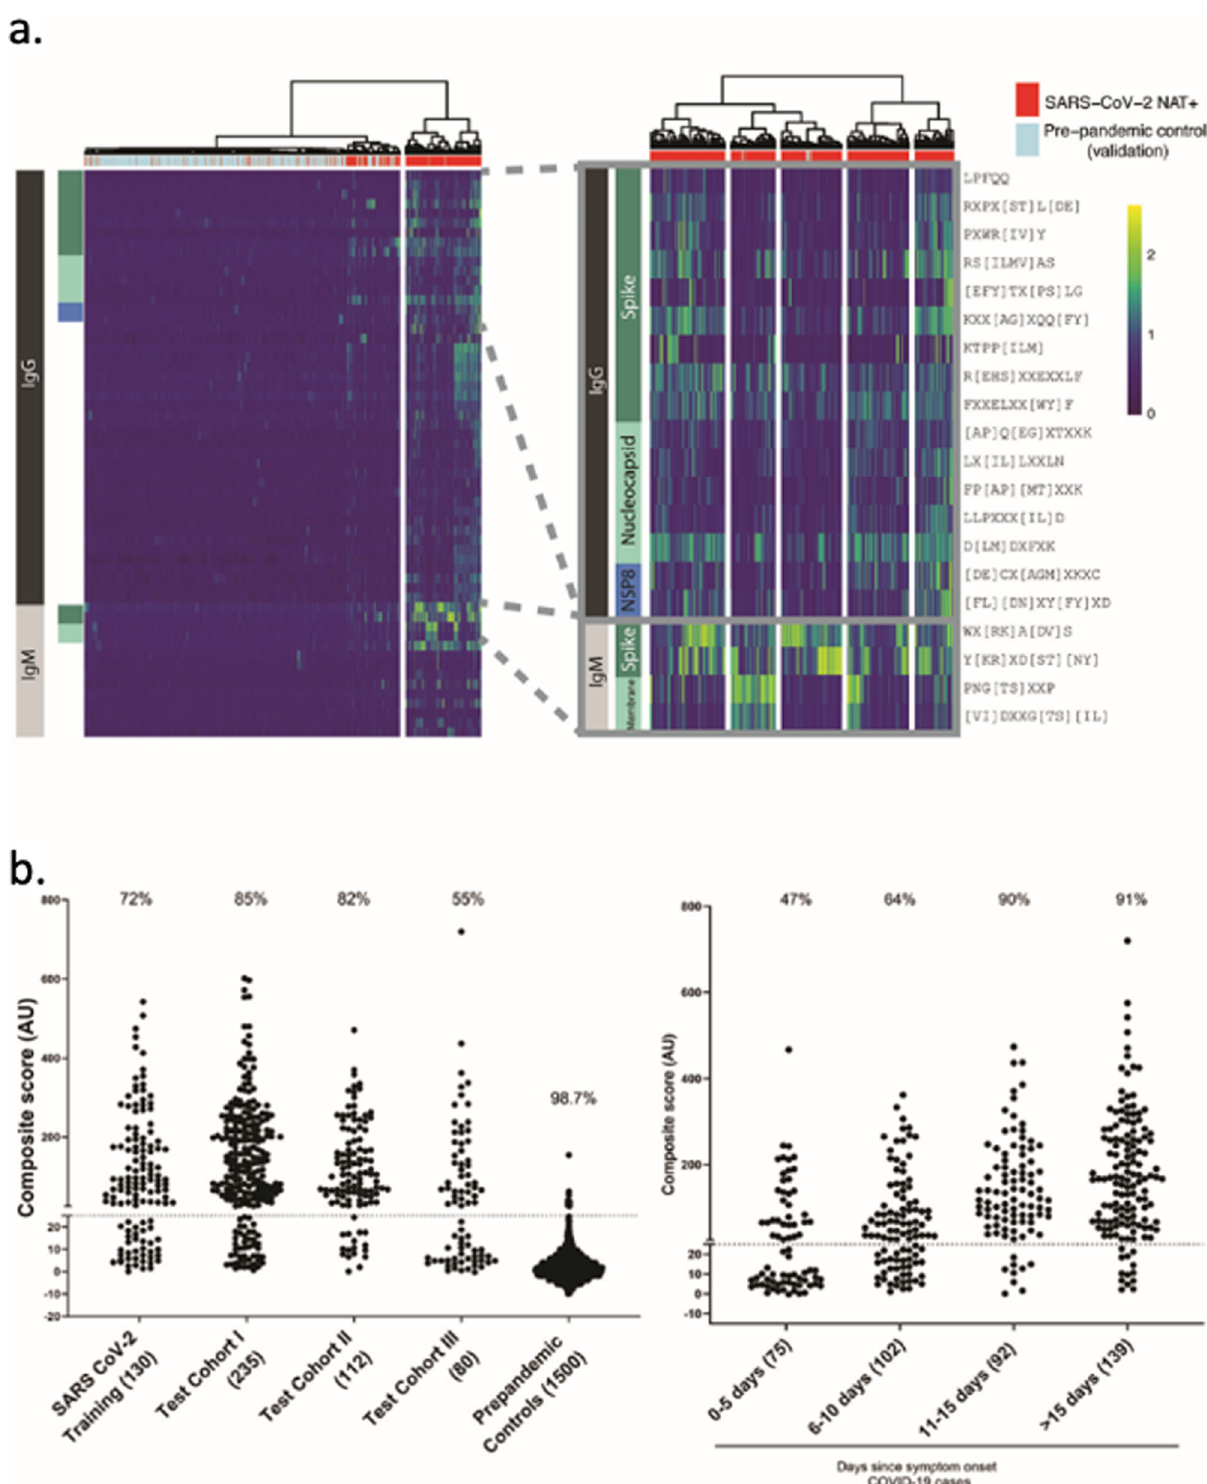
Fig. 3 IMUNE-based discovery of IgG and IgM motifs in the SARS-CoV-2 humoral immune response. a Heatmap of IgG and IgM motif log-enrichment values for 579 COVID-19 samples and 1500 pre-pandemic controls. Inset highlights motifs with linear epitope maps to SARS-CoV-2. b Sensitivity and speci fi city of the SARS-CoV-2 IgG/IgM diagnostic classi fi er in NAT + subjects and pre-pandemic controls. Z-scores for each motif were summed to generate an IgG/IgM composite score. The maximum value for the IgG or IgM for each sample i shown. Samples above a cutoff of 25 are classi fi ed as positive. The sensitivity or speci fi city of the SERA panels for all COVID-19 cohorts and controls is shown above each